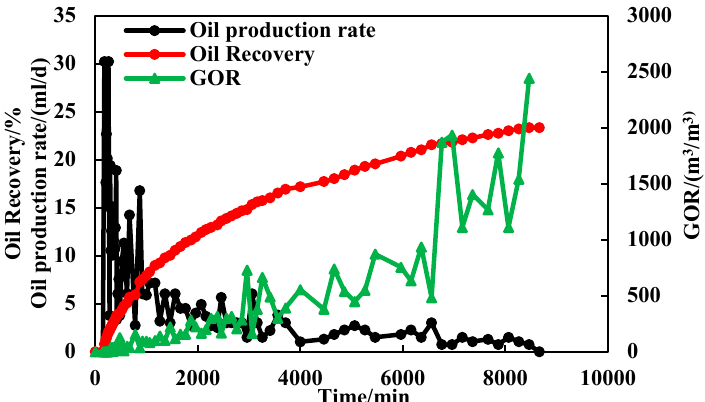
Figure 4. Production parameters of air flooding at different times.